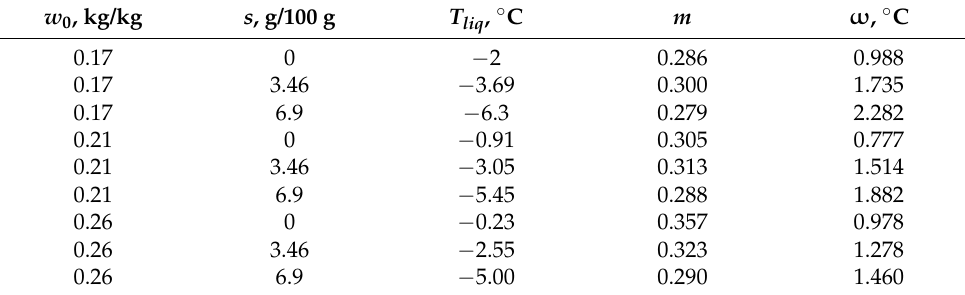
Table 3. Freezing Characteristic Curve